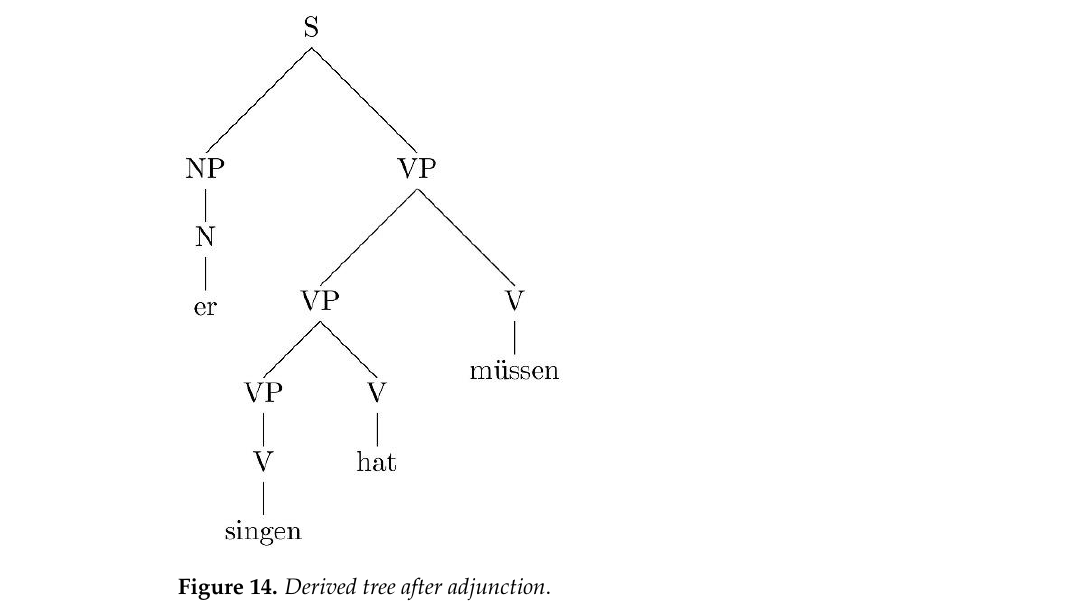
Figure 15. Elementary trees featuring V extraposition